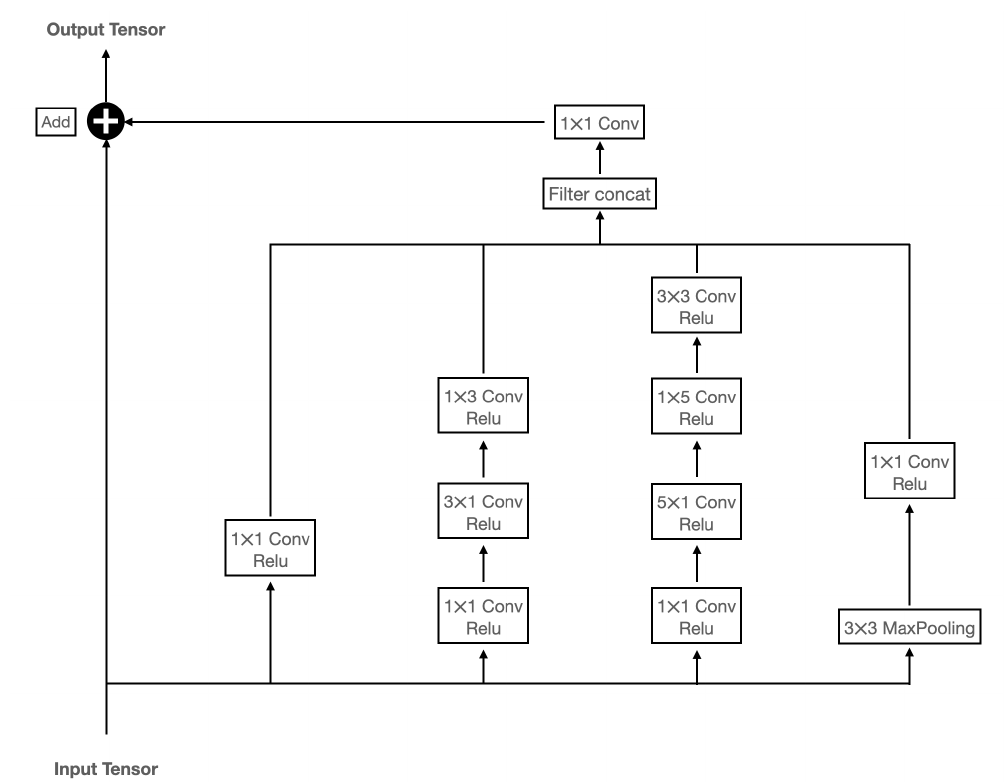
Figure 6. Inception-residual